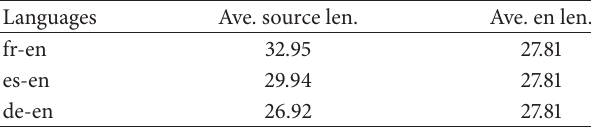
Table 6: Statistics of test data (3,064 sentences).